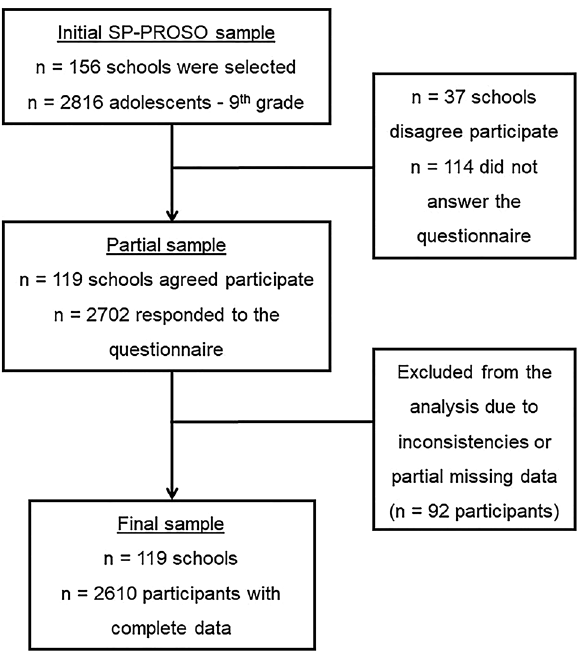
Figure 1. Flow chart of selection of SP-Proso